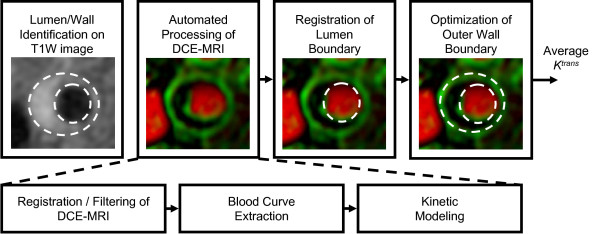
Contrast Enhanced MRI (DCE-MRI) with Kinetic Remodel. V-V image generated by the dynamic contrast enhanced MRI (DCE-MRI) with kinetic remodel. Illustration of the steps in creating a vasa vasorum image: boundaries drawn on a conventional contrast define a region of interest for processing. Within this region, DCE-MRI images are run through the KFRS algorithm, and then a blood curve (AIF) is automatically extracted and used for kinetic modeling. Finally, the boundaries are mapped to the resulting vasa vasorum image and Ktrans is measured in the wall. Reprinted, with permission from Ref [77].